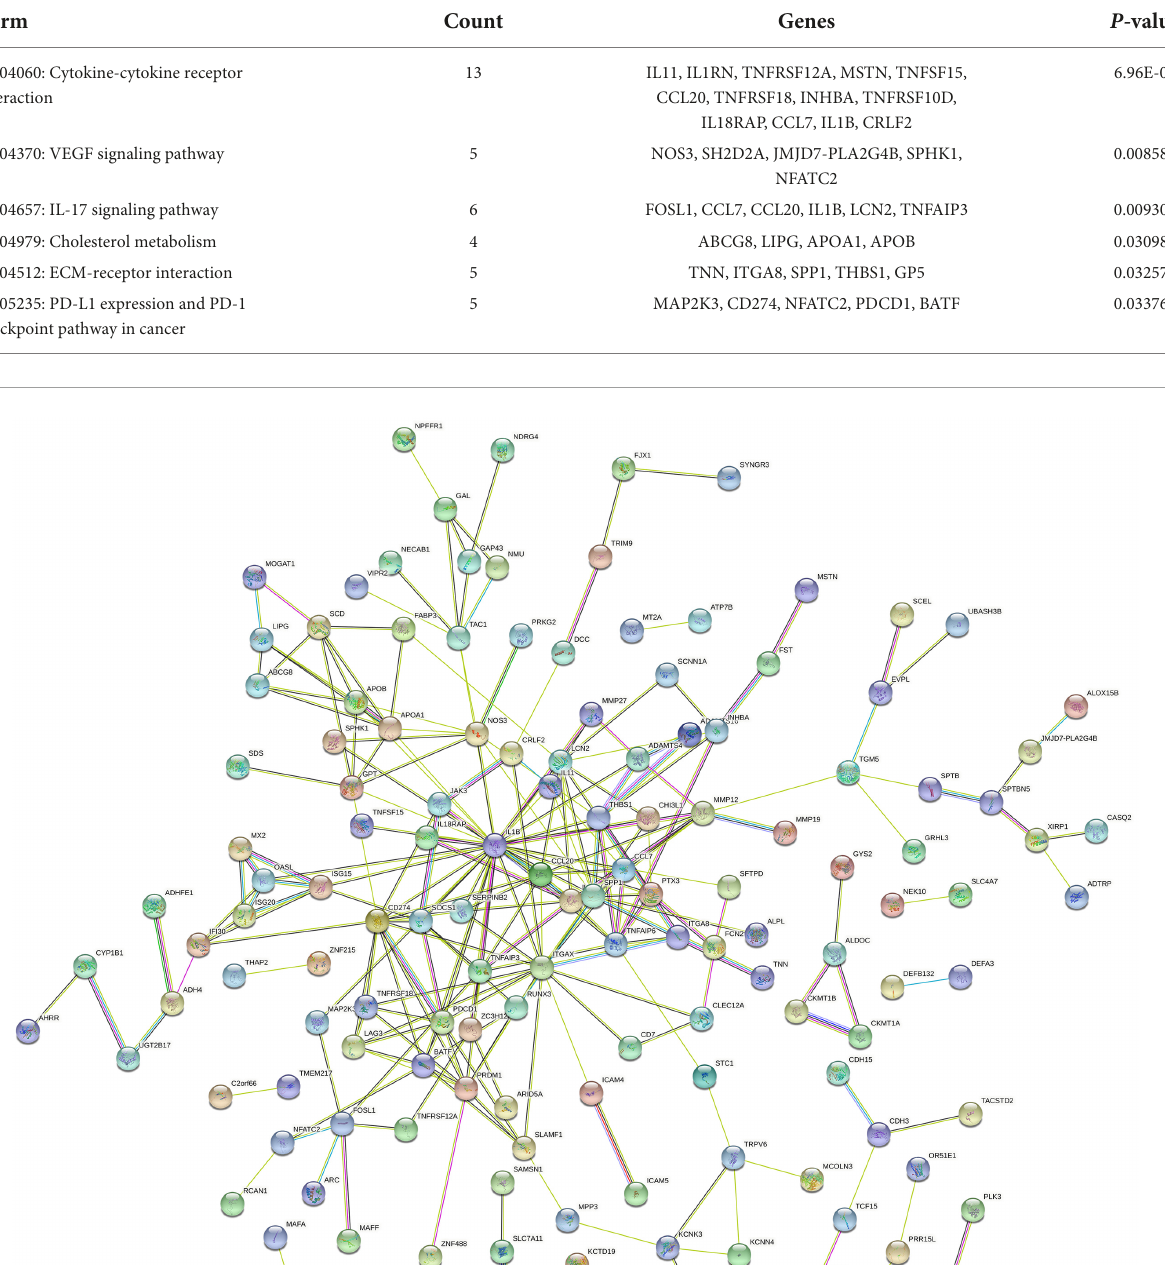
TABLE 2 The Kyoto Encyclopedia of Genes and Genomes (KEGG) pathway analysis of DEGs.